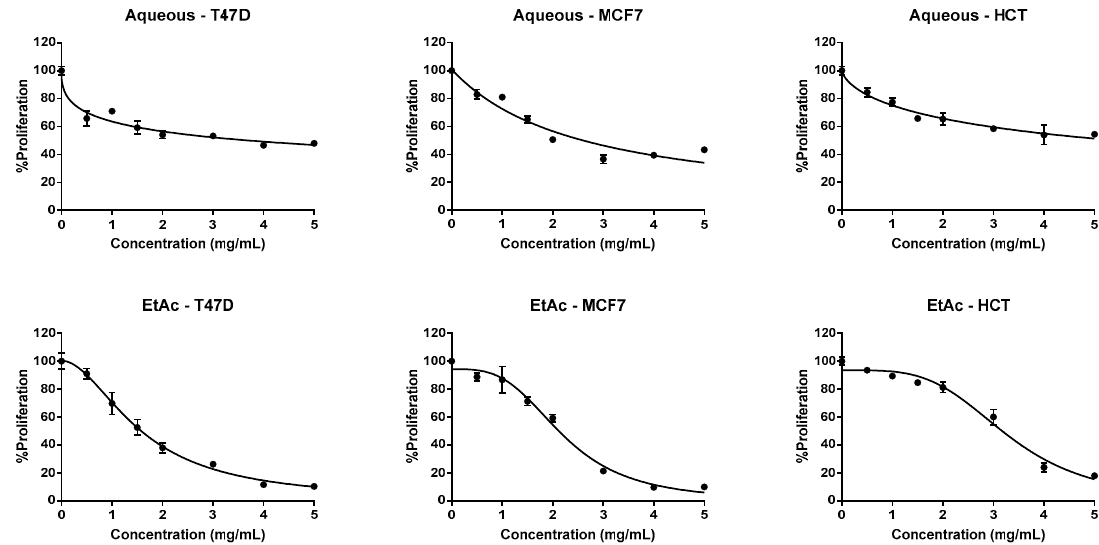
Figure 2. Antiproliferative activities of C. villosus extracts against three human cancer cell lines. Exposure time 48 h. Values are expressed as mean ± SD of three experiments.